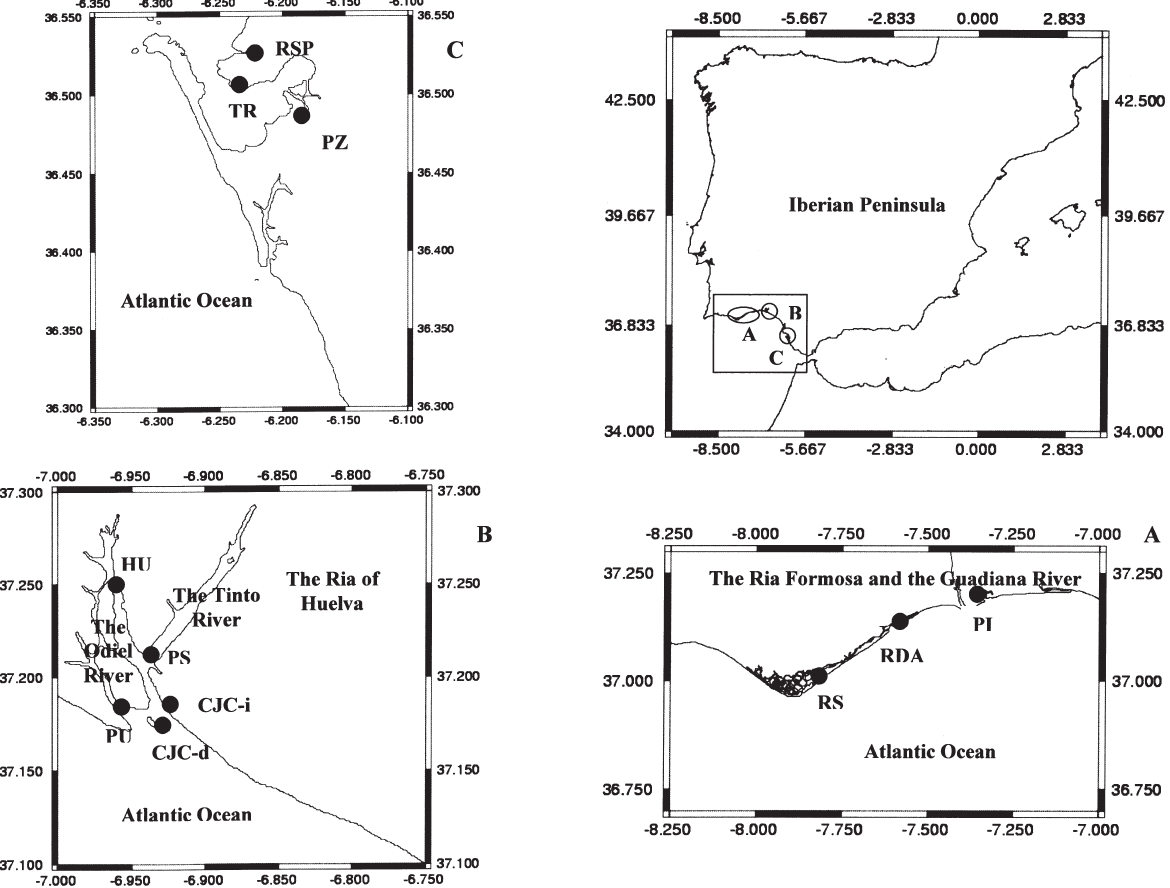
Fig . 1. – Location of sampling stations in the southwestern Iberian